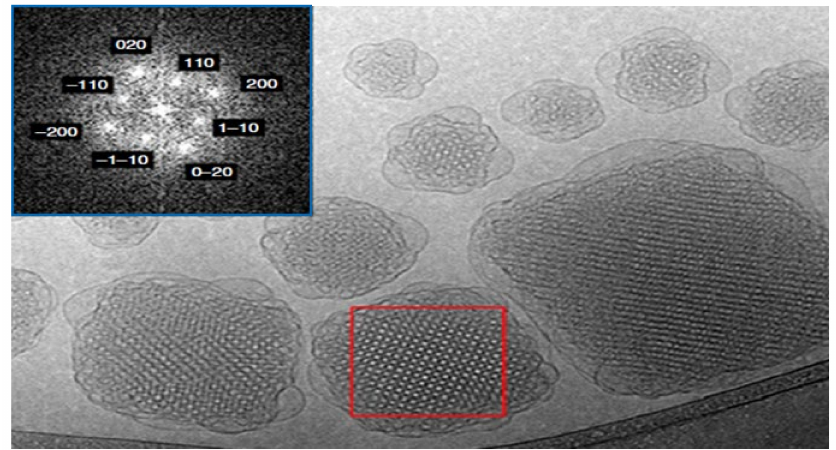
Figure 3. An image of a cubosome taken using cryogenic transmission electron microscopy (cry-TEM). The red box denotes the well-ordered structure created in the particles within and near the water matrix contact with a vesicular structure. The fast Fourier transform (FFT) of the red box region is shown in the photo inset in a blue-colored box and is utilized to determine the structure of the liquid-crystalline particles, which was also validated by SAXS analysis. Scale bar, 100 nm. Source: Reproduced from